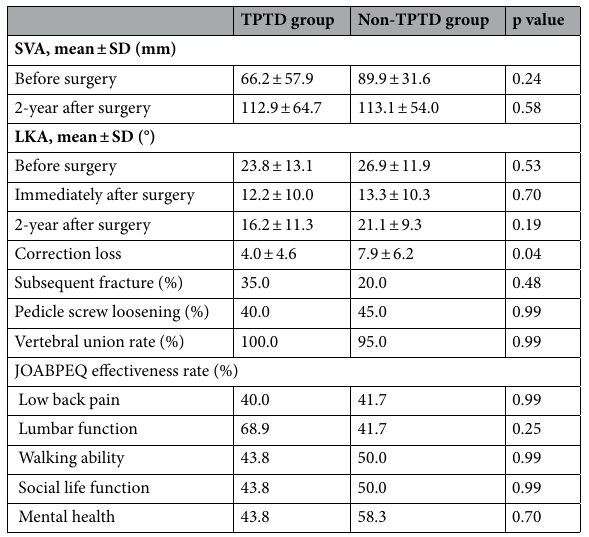
Table 4. Comparison of outcomes after propensity score matching. SD standard deviation, SVA sagittal vertical axis, LKA local kyphosis angle, JOABPEQ Japanese Orthopaedic Association Back Pain Evaluation